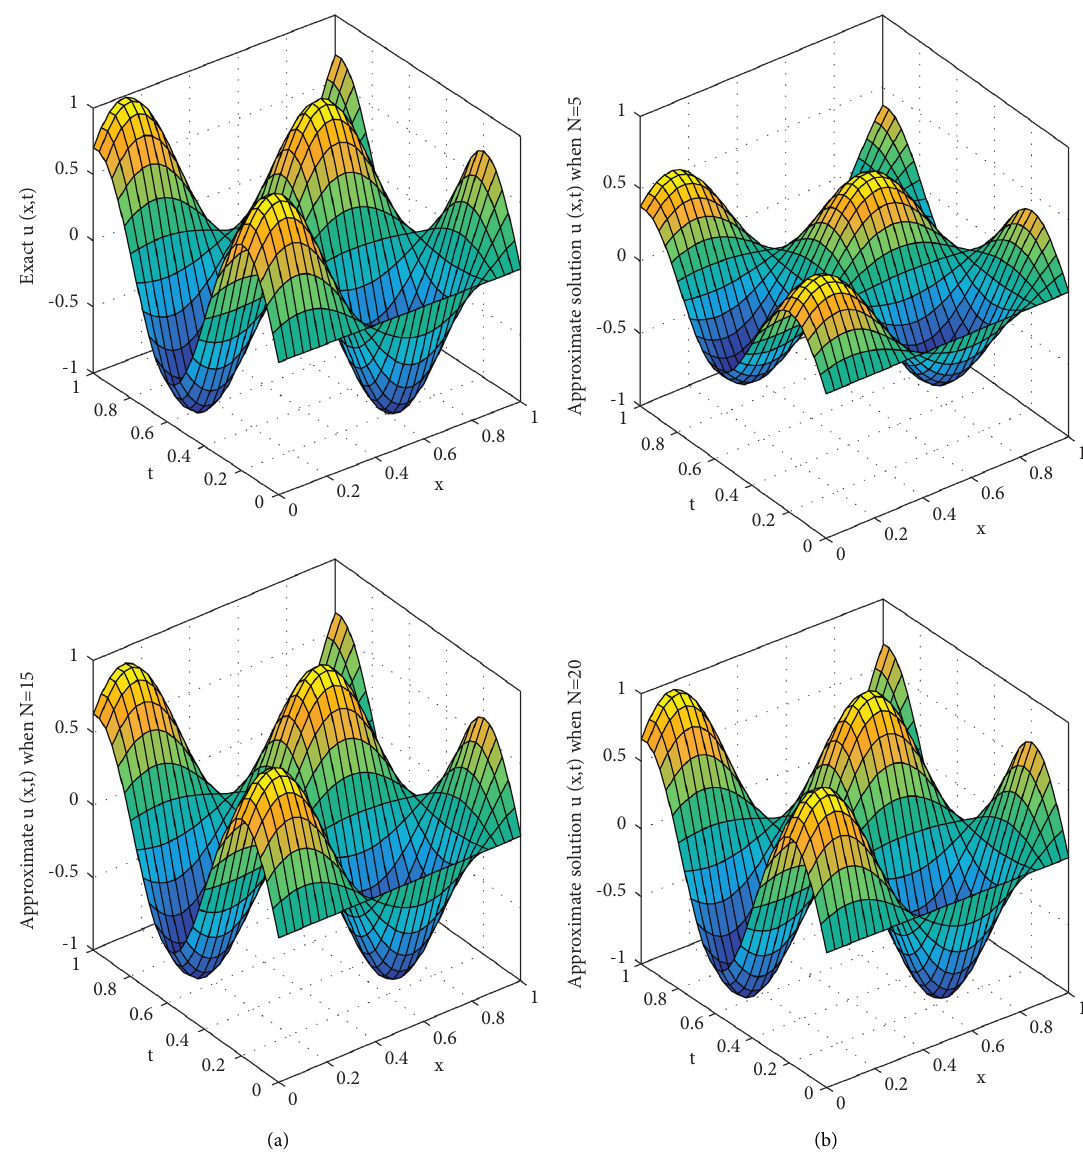
Figure 1: Reconstructions of Example 1. (a) First line: exact solution of u ( x,t ) (left); approximate solution of u ( x, t ) when N � 5 (right); (b) second line: approximate solutions of u ( x,t ) when N � 15 (left) and N � 20 (right), respectively.